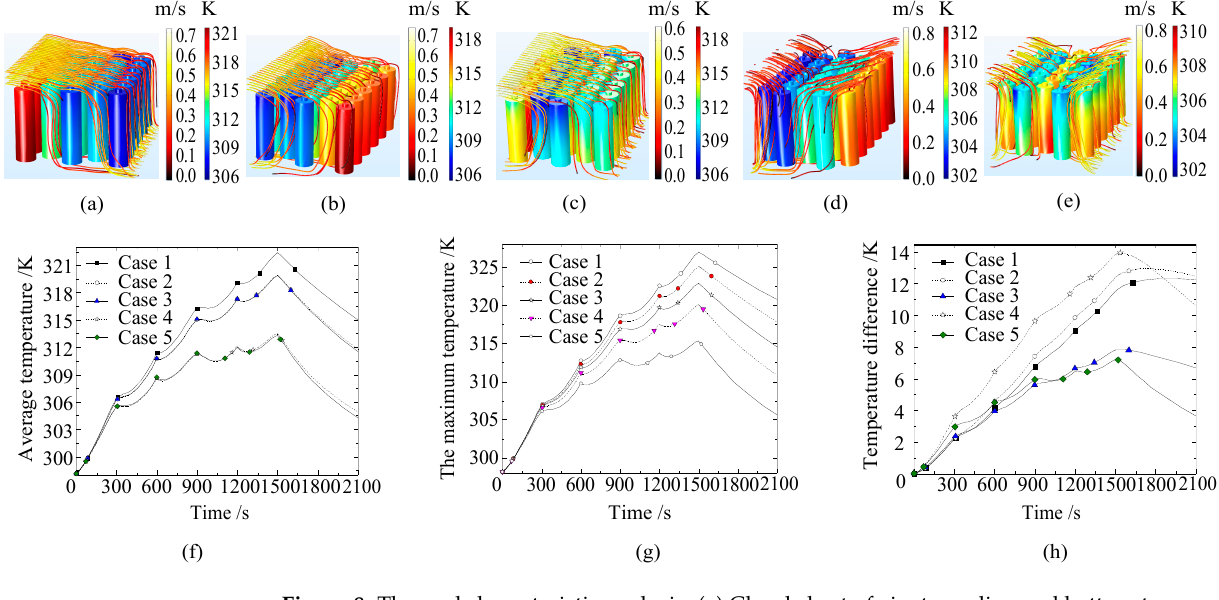
Figure 8. Thermal characteristic analysis. ( a ) Cloud chart of air streamline and battery temperature (case 1); ( b ) cloud chart of air streamline and battery temperature (case 2); ( c ) cloud chart of air streamline and battery temperature (case 3); ( d ) cloud chart of air streamline and battery temperature (case 4); ( e ) cloud chart of air streamline and battery temperature (case 5); ( f ) relationship between the average temperature and time; ( g ) relationship between the maximum temperature and time; and ( h ) temperature di ff erence versus time.